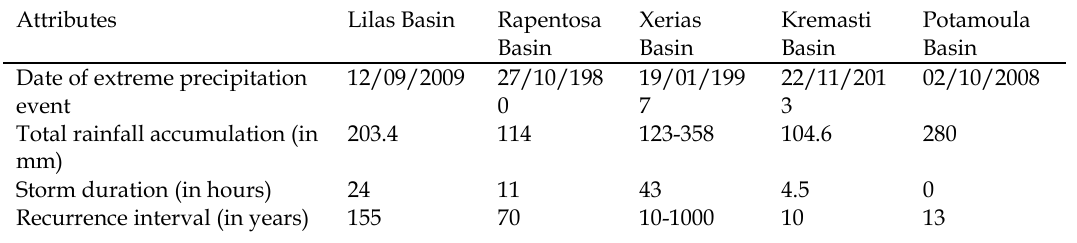
Table 2. Attributes of extreme weather events in the examined basins